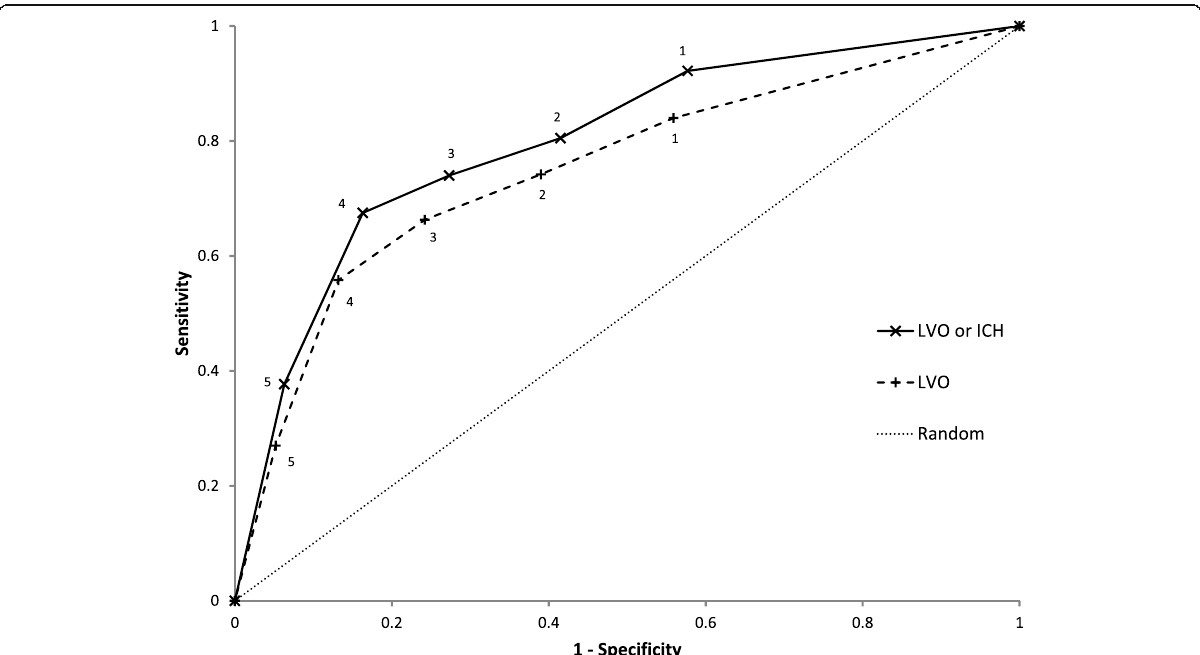
Fig. 2 Receiver operating characteristic curves of the Los Angeles Motor Scale at various cut-off scores for diagnosing large-vessel occlusion (LVO) selectively (dashed line) with an area under the curve of 0.798, or for diagnosing LVO or intracerebral haemorrhage (solid line) with an area under the curve of 0.751. Diagonal segments are produced by ties. The dotted line depicts